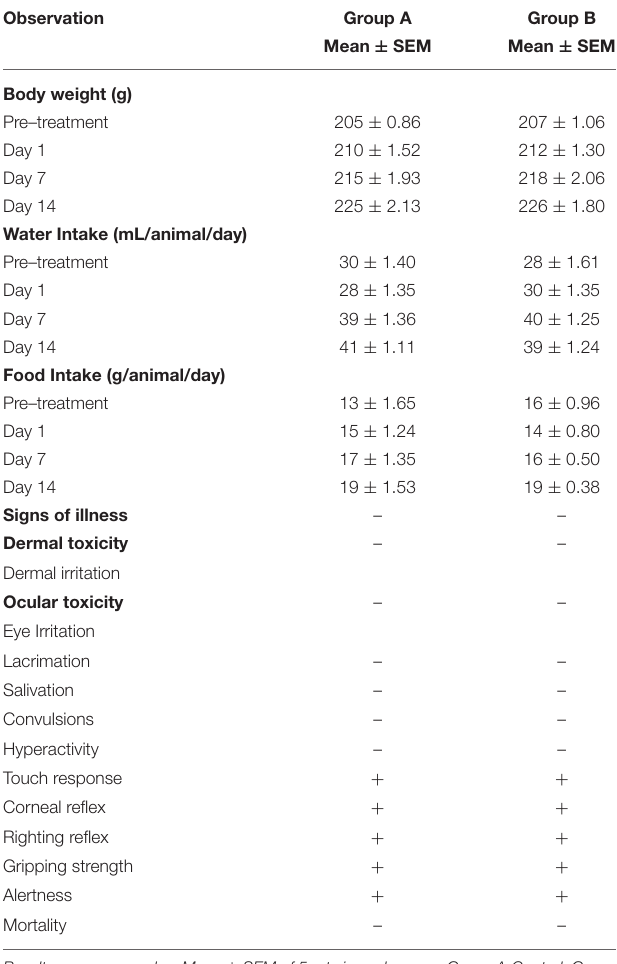
TABLE 4 | Clinical observation of control and hydrogel treated rats for acute oral toxicity